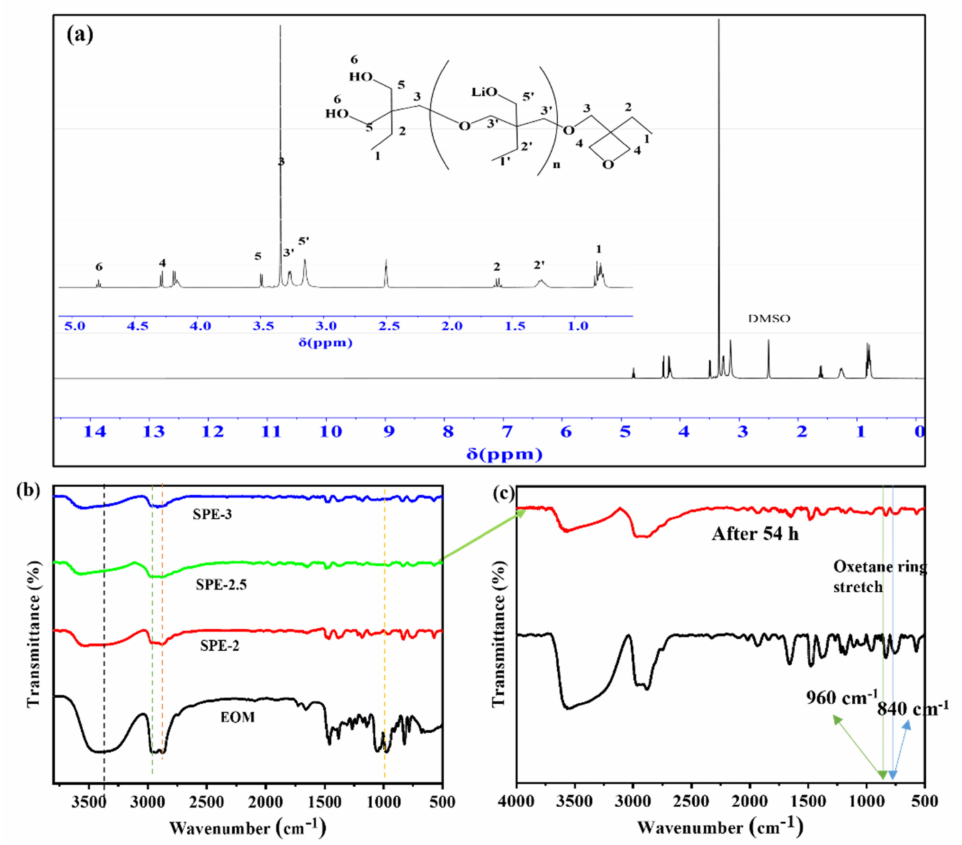
Figure 2. ( a ) 1 H-NMR spectra (inset shows the partial enlarged 1 H-NMR spectra) of SPE-2.5, ( b ) FTIR spectra of precursor EOM and SPEs and ( c ) initial transmittance and after 54 h of SPE-2.5.